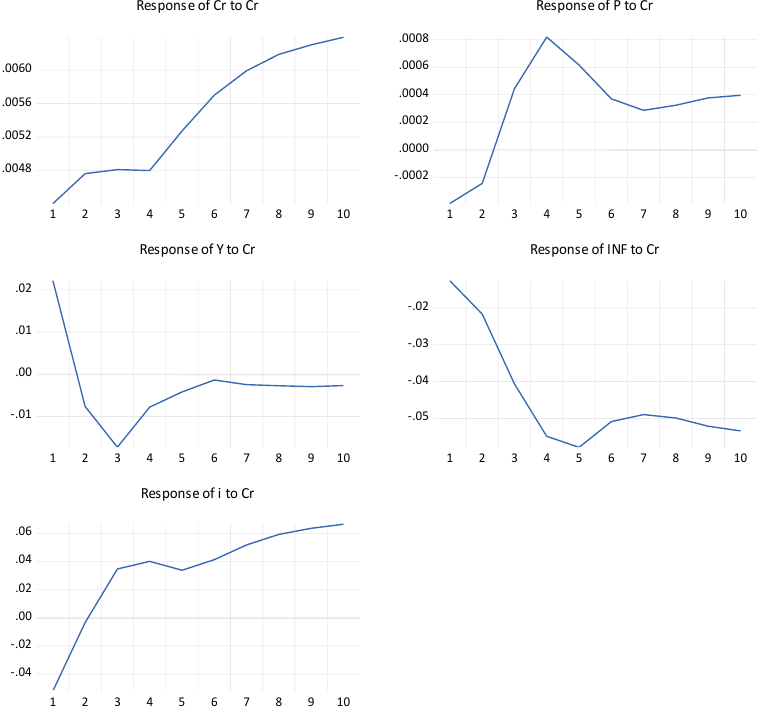
Figure 5. The response of mortgage credit volume to housing demand in Izmir, Turkey.